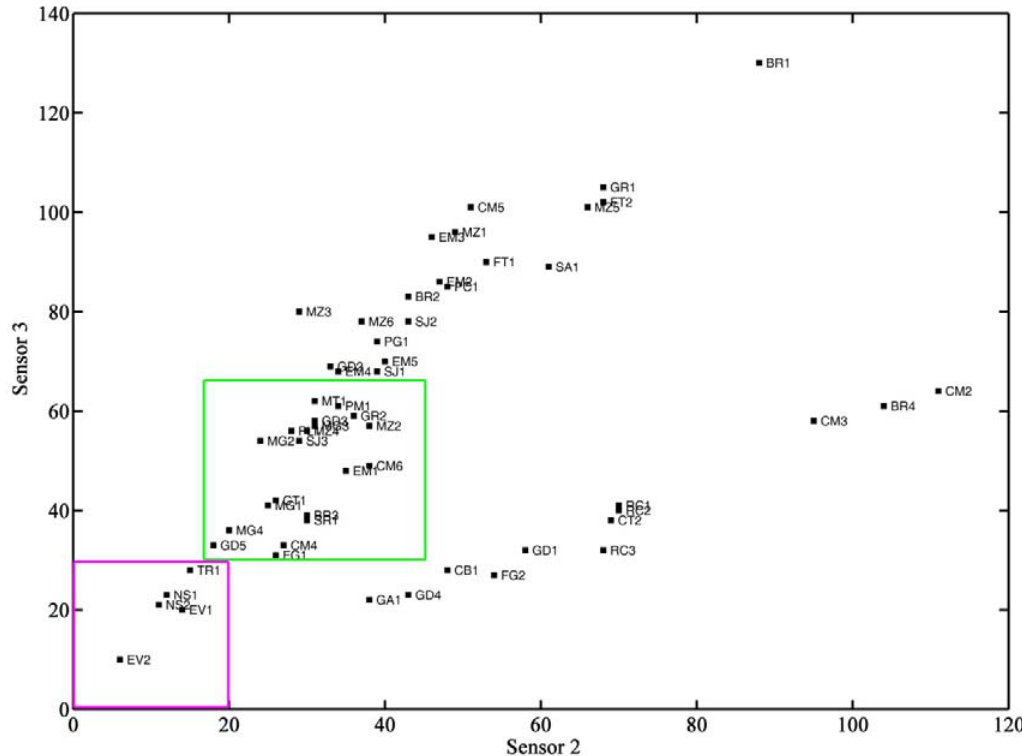
Figure 5. Plot of the responses of sensor 3 vs. sensor 2.